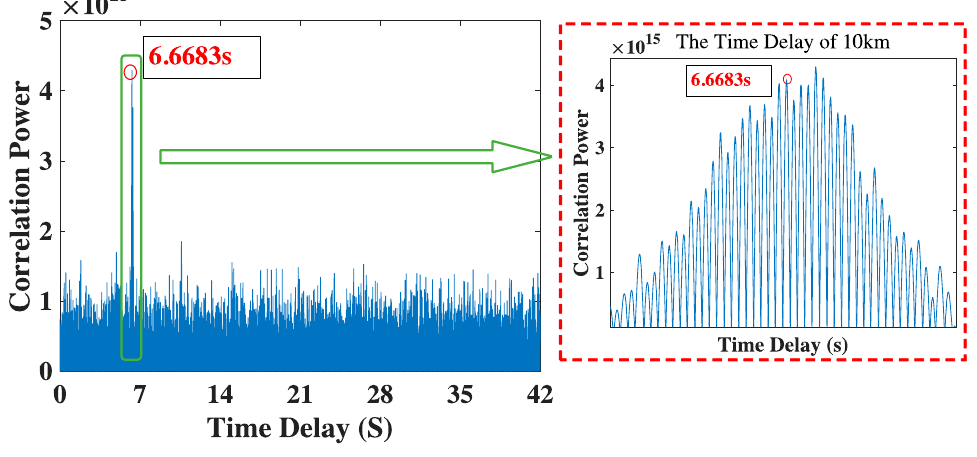
Figure 6. The time delay result of 10 km.